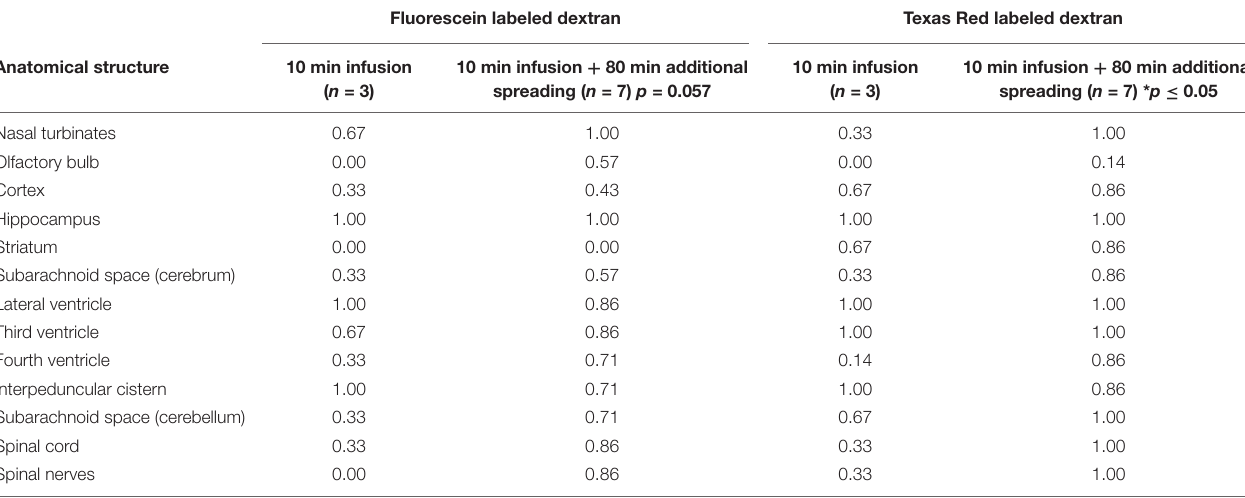
TABLE 1 | Proportion of mice that showed tracer presence in different anatomical structures. Fluorescein labeled dextran Texas Red labeled